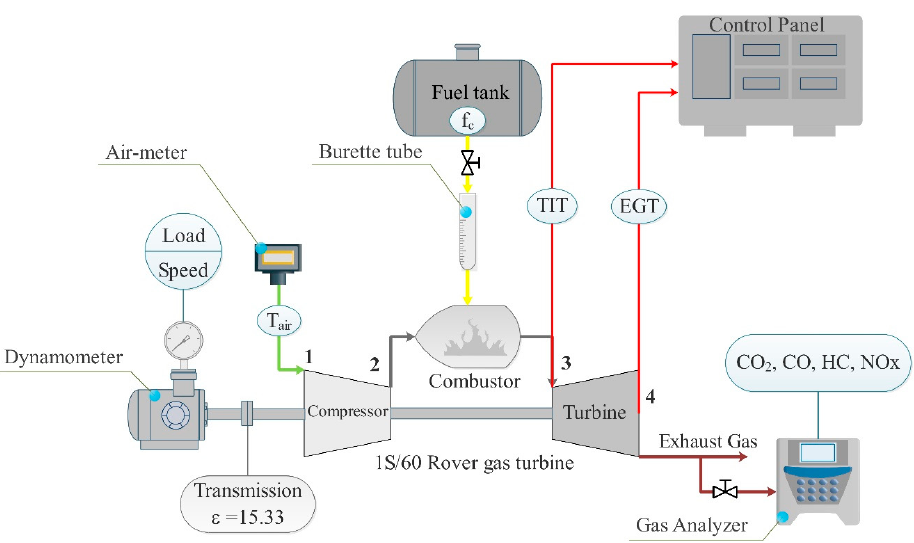
Figure 4. Schematic diagram of experimental test rig. From [32]. Table 4. Specifications of 1S/60 Rover gas ‐ turbine engine. Adapted from [32].